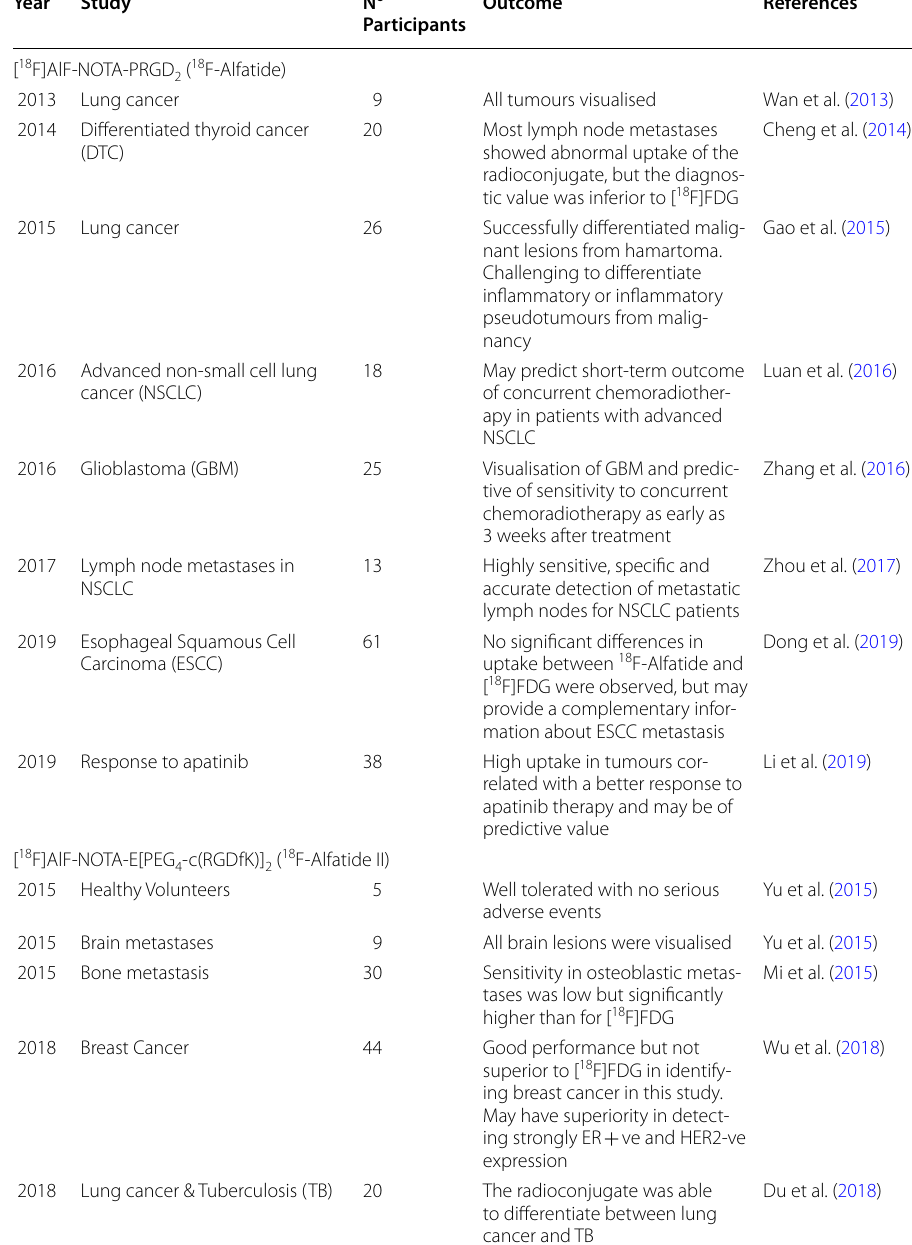
Table 5 Clinical PET studies using [ 18 F]AlF-NOTA-PRGD c(RGDfK)] ( 18 F-Alfatide 2